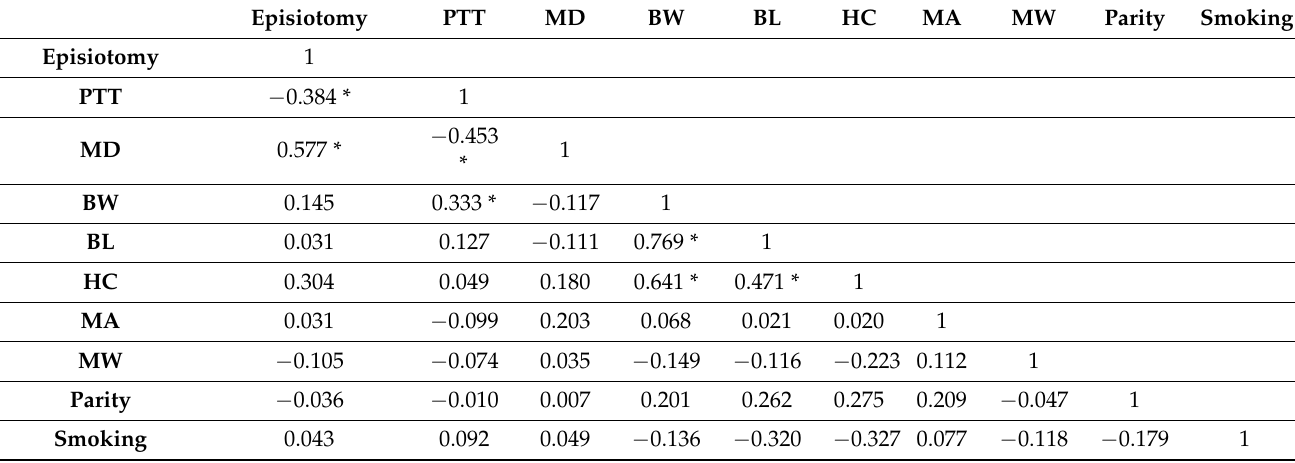
BL, birth length; BW, birth weight; HC, head circumference; MA, maternal age; MW, maternal weight; MD, mode of delivery; PTT, perineal tear type. * Statistically significant. The correlation matrix in the CG between maternal, childbirth, and newborn variables is shown in Table 3. Episiotomy was negatively correlated with the type of perineal tear ( r = − 0.384; p = 0.007). Mode of delivery was positively correlated with episiotomy ( r = 0.577; p < 0.001) and negatively correlated with type of perineal tear ( r = − 0.453; p = 0.001). Head circumference was positively associated with birth weight ( r = 0.641; p < 0.001) and length ( r = 0.471; p = 0.009). Moreover, birth weight was positively associated with birth length ( r = 0.769; p < 0.001) and type of perineal tear ( r = 0.333; p = 0.038). Table 3. Correlation matrix in the CG between maternal, childbirth, and newborn variables.